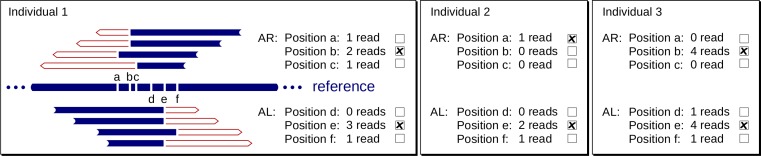
Example instance of our two-level voting system that determines the exact breakpoints of an Alu insertion.At the first level, split-reads vote for a left and right breakpoint position within each individual. At the second level, individuals vote for the positions that received the largest numbers of votes at the first level to choose the final breakpoint positions AL and AR. In this example, position b is elected as AR and position e is elected as AL.